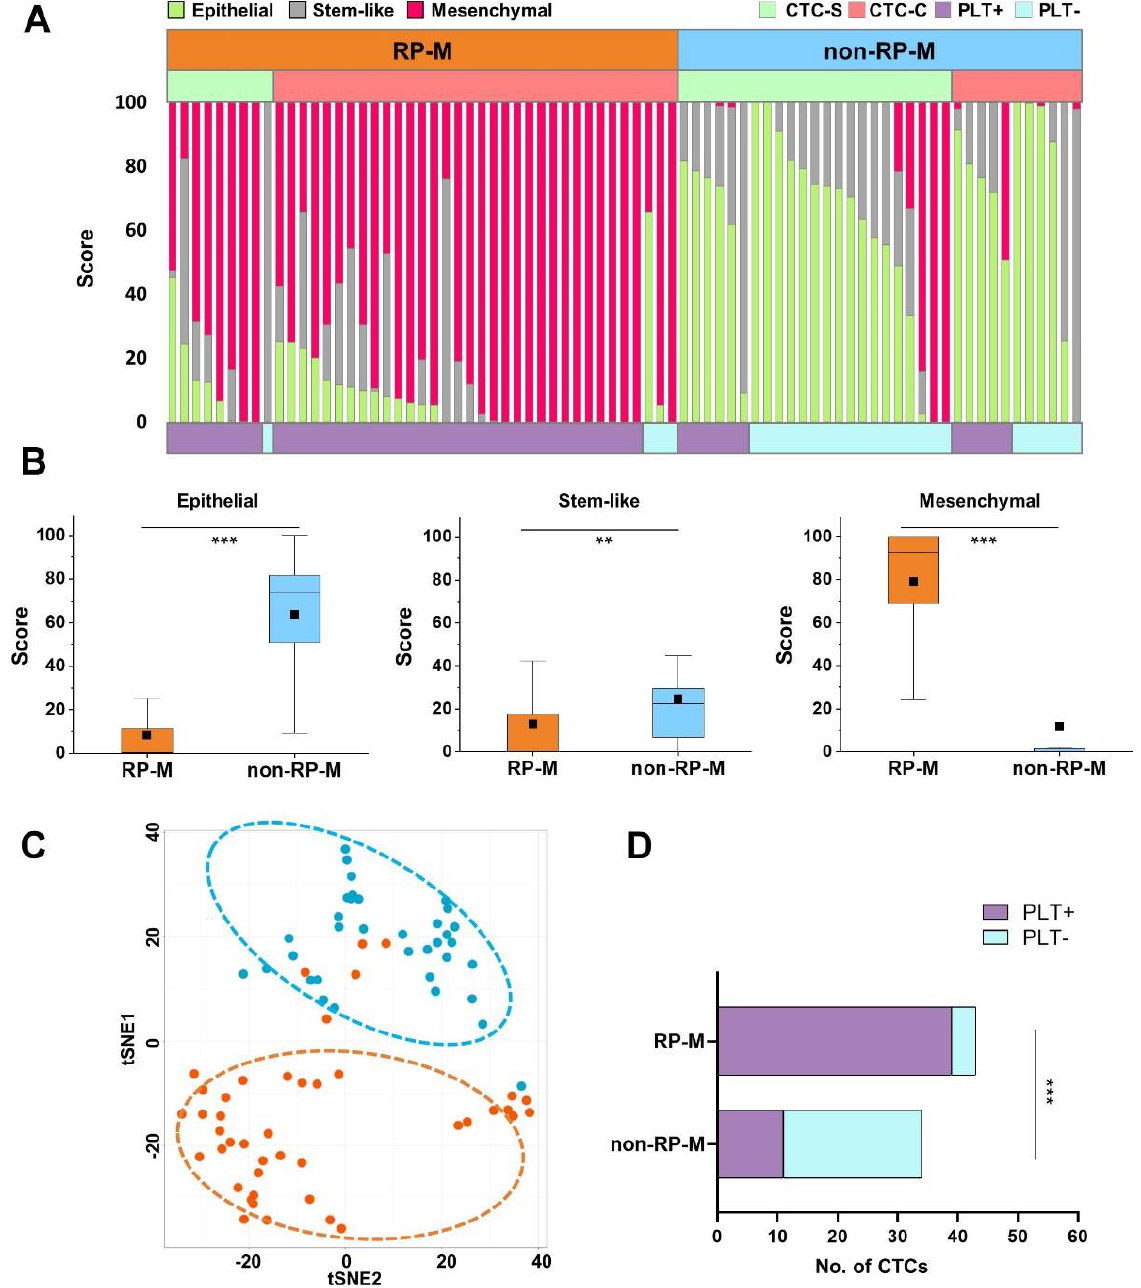
Figure 4. Circulating tumor cell (CTC) characterization according to the progression. ( A ) CTC classification into three categories between the rapid progression in metastasis (RP-M) group and the non-rapid progression in metastasis (non-RP-M) group according to subtypes: (1) CTC-S (single CTC) or CTC-C (CTC cluster) and (2) PLT+ group (platelet marker-positive group) or PLT− group (platelet marker-negative group). ( B ) The score of the three categories between the RP-M group and non-RP-M group (** p < 0.01, *** p < 0.001). ( C ) Two-dimensional t-SNE analysis based on hierarchical clustering between the RP-M group and non-RP-M group. ( D ) Fisher’s exact test based on the analysis of contingency tables between the RP-M and non-RP-M groups according to the platelet marker expression ( p < 0.0001). t-SNE, t-distributed stochastic neighbor